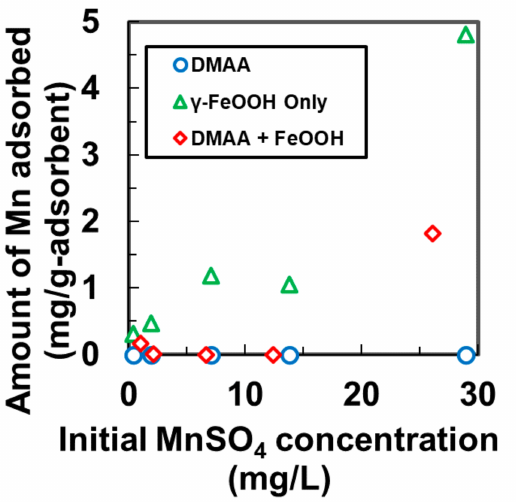
Figure 2. Amount of Mn adsorbed by DMAA, γ -FeOOH, and DMAA + FeOOH at different initial MnSO 4